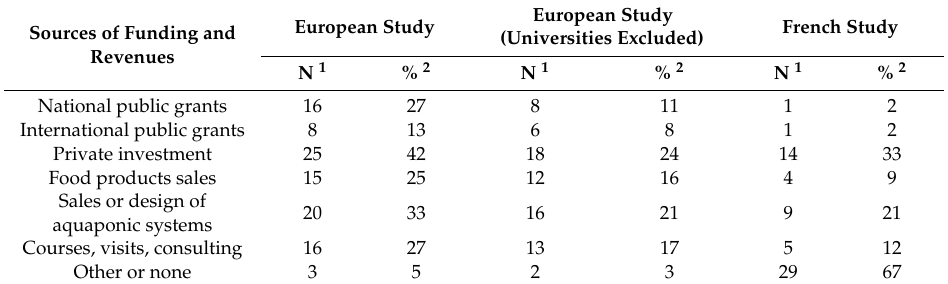
Table 2. Answers to the question: Could you please share with us more detail about the source of revenue for your aquaponics